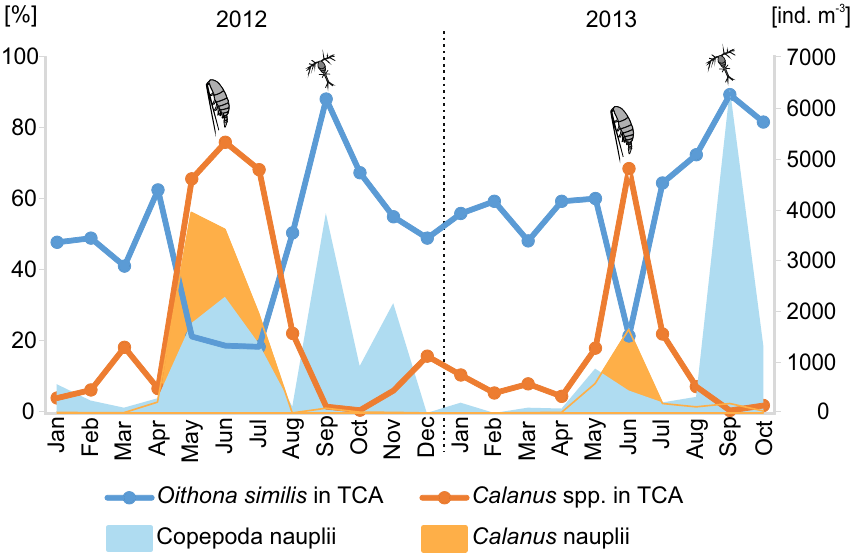
Figure 5. Oithona similis and Calanus spp. relative abundance (%) in Total Copepoda Abundance (TCA) and total abundance (ind. m -3 ) of Copepoda nauplii and Calanus